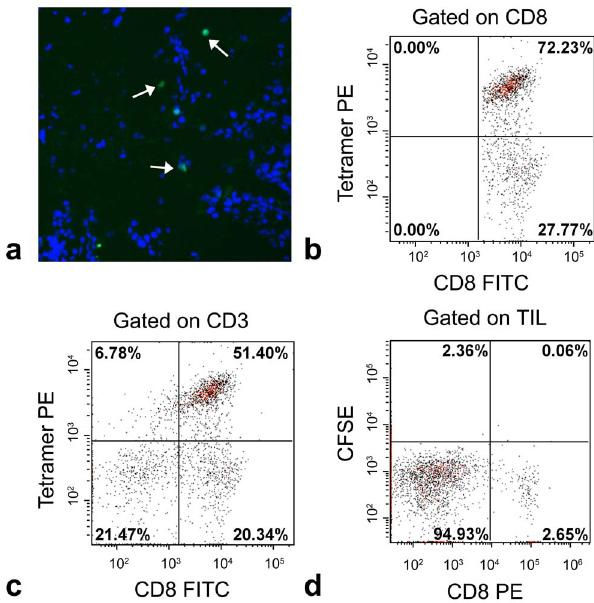
Figure 4. Exvivo analysis shows the infiltration of CD8 + T cells to brain and glioma. Panel A shows IHC of fluorescently labeled Pmel-1 CD8 + T cells. Animals were infused with T cells (2 6 10 7 ) and sacrificed for IHC staining two days after cell infusion. Sparse T cells are shown at the arrows. Panels B–C show quantitative flow cytometry of Pmel-1, hgp100-specific T cells in brain cell suspension with CD8 + ( B ) and CD3 + ( C ) gating. Panel D shows quantitative flow cytometry of wild-type T cells. Here, PE=Phycoerythrin, FITC=Fluorescein isothiocy- anate, and TIL=tumor infiltrating lymphocytes. after a single infusion of the potent chemotherapeutic agent bis- chloroethylnitrosourea (BCNU).